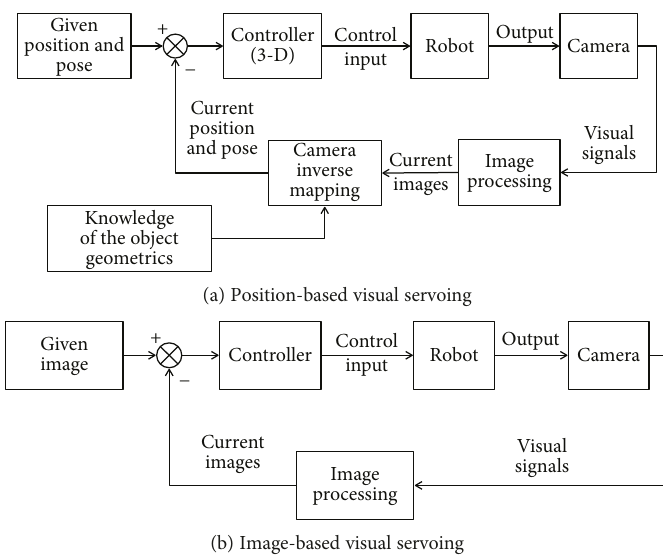
Figure 1: Visual servoing control scheme